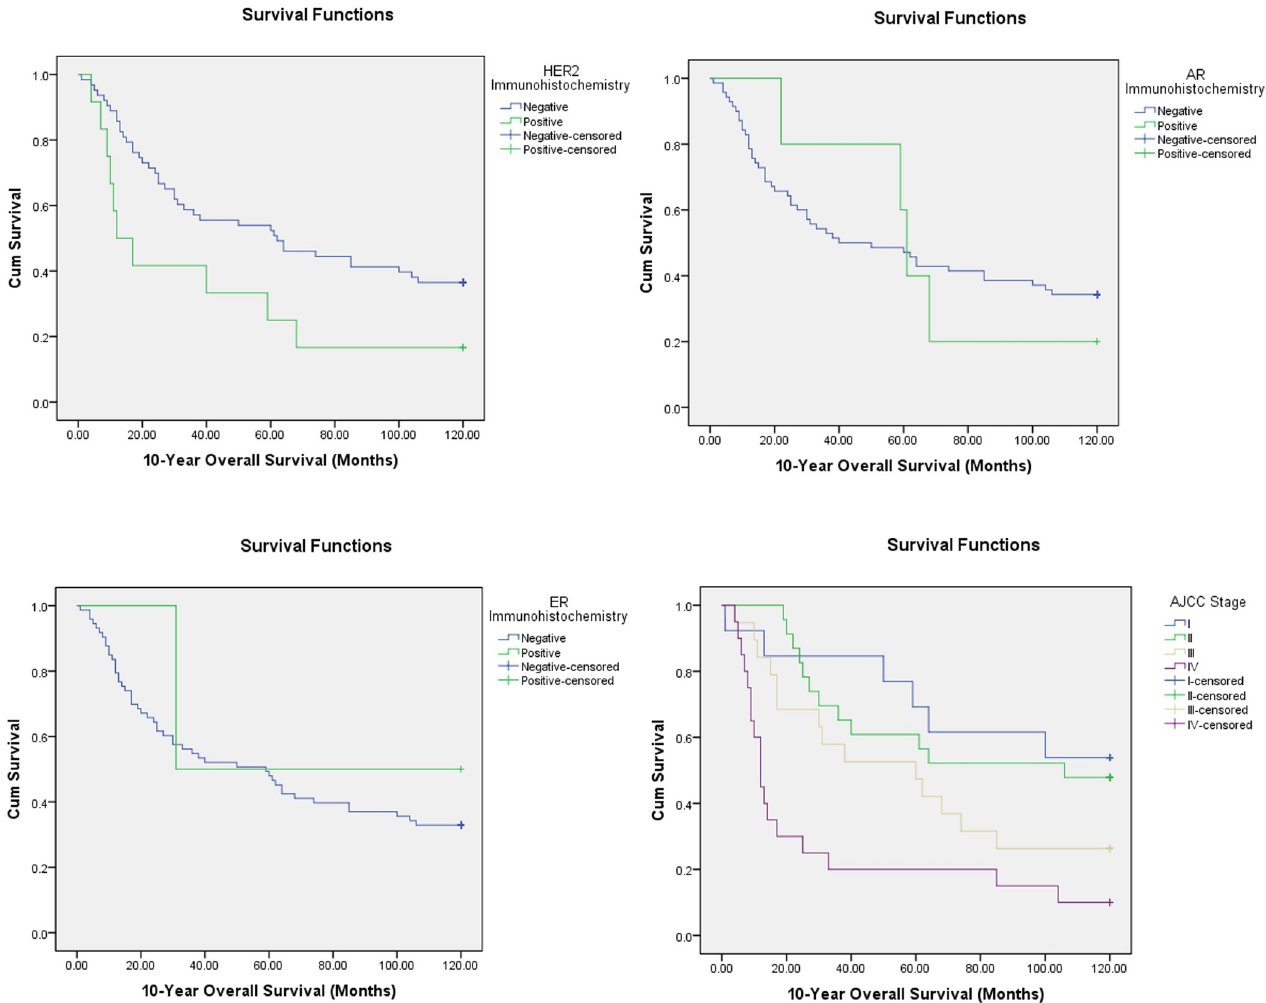
Fig 2. Kaplan-Meier curve analysis for 10-year survival showing Her-2 positive ( P = 0.041) and higher AJCC stage ( P < 0.001) patients with markedly lower survival. There were no significant differences in survival on the basis of AR ( P = 0.913) and ER ( P = 0.615) expression.